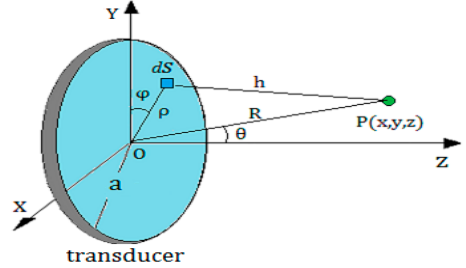
Figure 2. The geometry of the sound field generated by a round piston transducer.